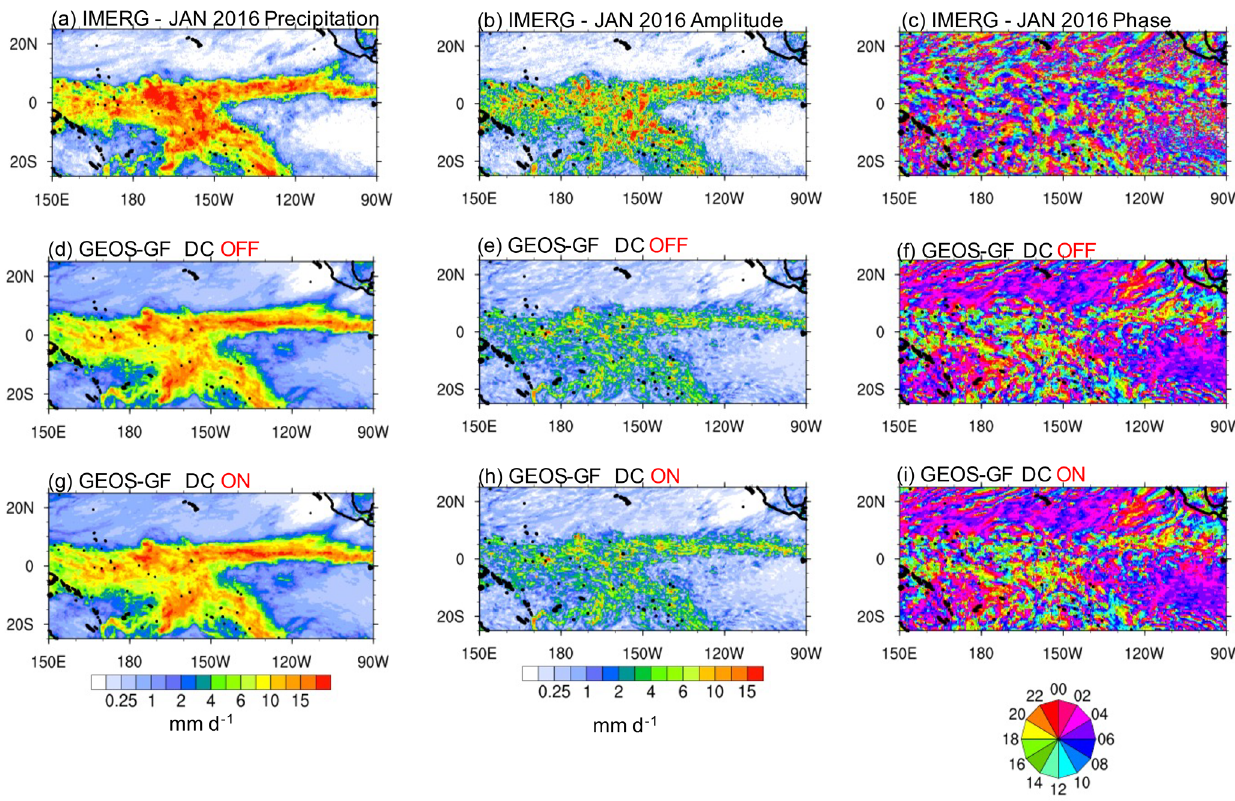
Figure 15. The January 2016 monthly mean precipitation, amplitude, and phase of the diurnal harmonic over the tropical Pacific Ocean. The top panels (a–c) show the quantities of the GPM IMERG retrieval. In the middle (d–f) and lower rows (g–i) , panels show model simulations with the diurnal cycle closure turned off and on,